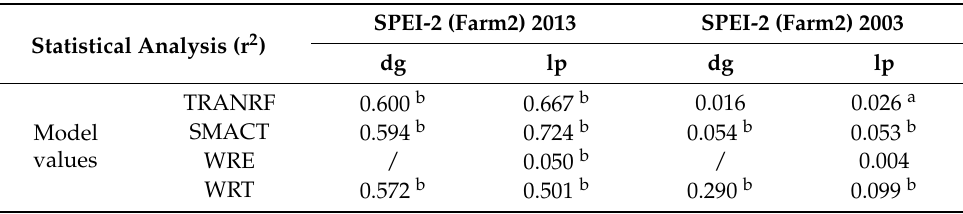
Table 6. Statistical analysis of drought index SPEI-2 at Farm2 and the LINGRA-N model results of yield (TRANRF, SMACT, WRE, WRT) for years 2013 and 2003—shown are values of r 2 . Statistical Analysis (r 2